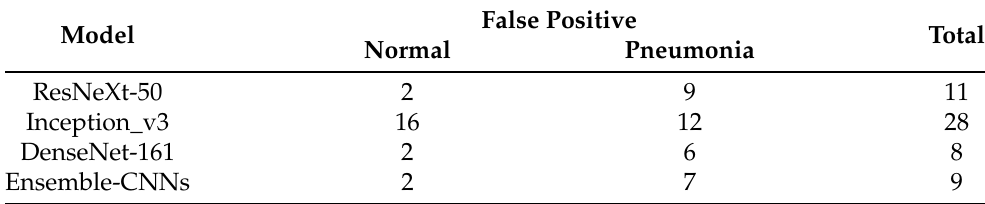
Table 9. False positive of the testing three-class split for the COVID-19 class.